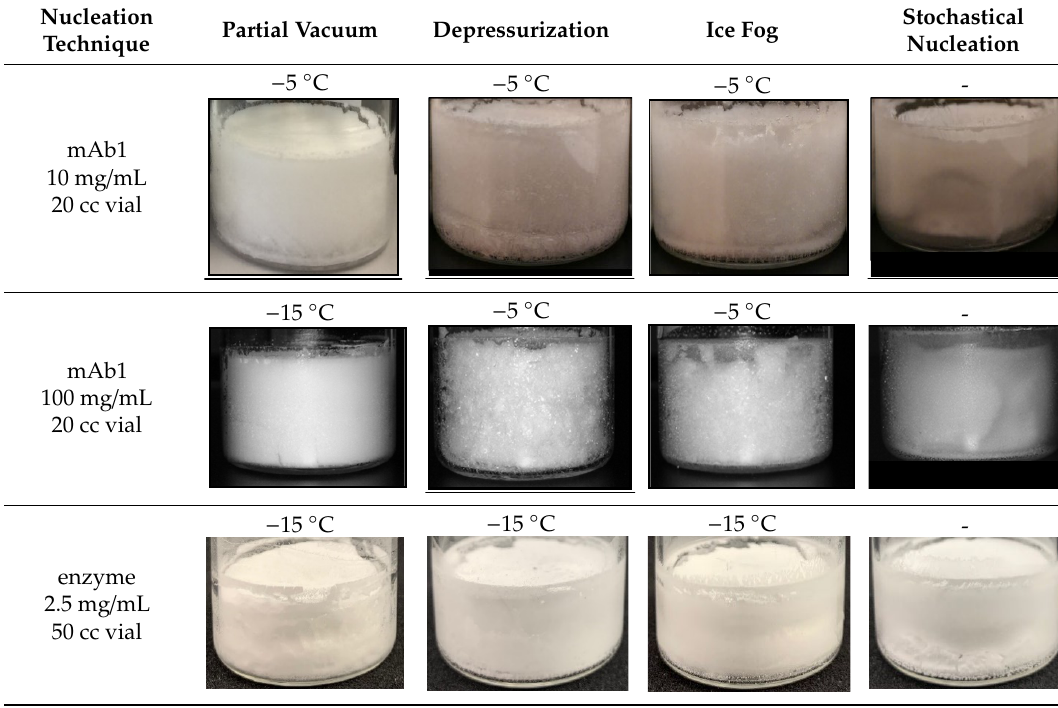
monomer content (SEC) nor in changes in iso-Aspartate formation (IEC). The data is summarized in Table A1 in the Appendix A. Table 3. Cake appearance by visual inspection. Representative pictures for the three formulations Table 3. Cake appearance by visual inspection. Representative pictures for the three formulations Table 3. Cake appearance by visual inspection. Representative pictures for the three formulations Table 3. Cake appearance by visual inspection. Representative pictures for the three formulations Table 3. Cake appearance by visual inspection. Representative pictures for the three formulations lyophilized in 20 cc vials using the three di ff erent nucleation techniques compared to stochastically Table 3. Cake appearance by visual inspection. Representative pictures for the three formulations Table 3. Cake appearance by visual inspection. Representative pictures for the three formulations Table 3. Cake appearance by visual inspection. Representative pictures for the three formulations Table 3. Cake appearance by visual inspection. Representative pictures for the three formulations lyophilized in 20 cc vials using the three different nucleation techniques compared to stochastically lyophilized in 20 cc vials using the three different nucleation techniques compared to stochastically lyophilized in 20 cc vials using the three different nucleation techniques compared to stochastically lyophilized in 20 cc vials using the three different nucleation techniques compared to stochastically Table 3. Cake appearance by visual inspection. Representative pictures for the three formulations Table 3. Cake appearance by visual inspection. Representative pictures for the three formulations Table 3. Cake appearance by visual inspection. Representative pictures for the three formulations Table 3. Cake appearance by visual inspection. Representative pictures for the three formulations nucleated samples. Nucleation temperatures are indicated above the pictures. lyophilized in 20 cc vials using the three different nucleation techniques compared to stochastically lyophilized in 20 cc vials using the three different nucleation techniques compared to stochastically lyophilized in 20 cc vials using the three different nucleation techniques compared to stochastically lyophilized in 20 cc vials using the three different nucleation techniques compared to stochastically nucleated samples. Nucleation temperatures are indicated above the pictures. nucleated samples. Nucleation temperatures are indicated above the pictures. nucleated samples. Nucleation temperatures are indicated above the pictures. nucleated samples. Nucleation temperatures are indicated above the pictures. lyophilized in 20 cc vials using the three different nucleation techniques compared to stochastically lyophilized in 20 cc vials using the three different nucleation techniques compared to stochastically lyophilized in 20 cc vials using the three different nucleation techniques compared to stochastically lyophilized in 20 cc vials using the three different nucleation techniques compared to stochastically nucleated samples. Nucleation temperatures are indicated above the pictures. nucleated samples. Nucleation temperatures are indicated above the pictures. nucleated samples. Nucleation temperatures are indicated above the pictures. nucleated samples. Nucleation temperatures are indicated above the pictures. nucleated samples. Nucleation temperatures are indicated above the pictures. nucleated samples. Nucleation temperatures are indicated above the nucleated samples. Nucleation temperatures are indicated above the pictures. nucleated samples. Nucleation temperatures are indicated above the pictures.